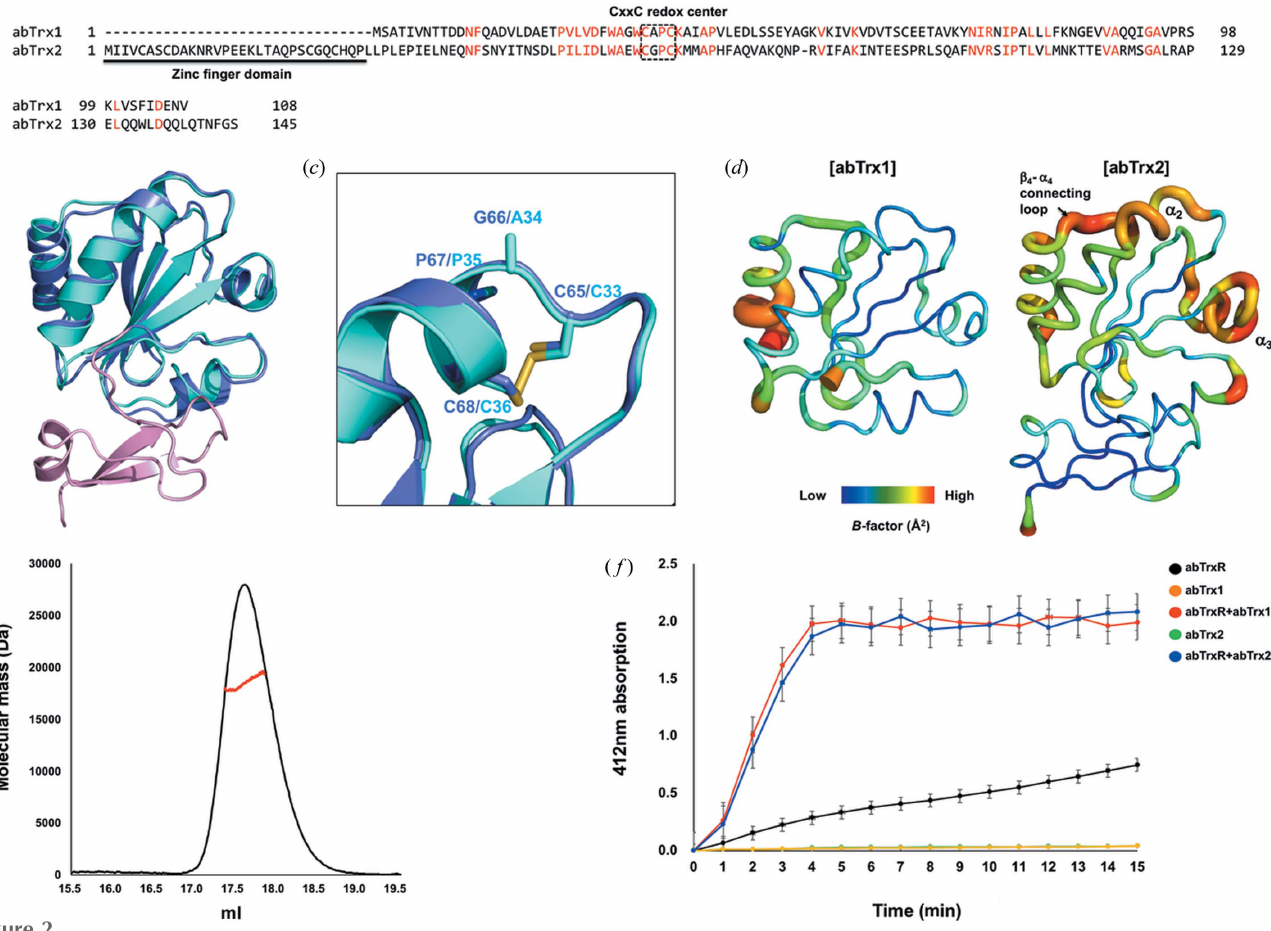
Figure 2 Structure and activity comparison of abTrx2 with abTrx1. ( a ) Sequence alignment of abTrx2 with abTrx1. Conserved residues are marked in red. ( b ) Superimposition of abTrx1 (cyan) and abTrx2 (blue and pink) for structural comparison. ( c ) A magnified view of the CxxC redox centers from the superposed structures of abTrx1 (cyan) and abTrx2 (blue). Residues forming the CxxC redox centers are labeled. ( d ) Comparison of B -factor distribution between abTrx1 and abTrx2. Putty representations are provided for visualizing B -factor distribution. ( e ) A MALS profile derived from the main SEC peak of abTrx2. The experimental MALS data (red line) are plotted as SEC elution volume ( x axis) versus absolute molecular mass ( y axis) distributions on the SEC chromatogram (black) at 280 nm. ( f ) Trx activity analysis by DTNB reduction assay. The reduction of DTNB by abTrxR was tested in the presence of abTrx1 and abTrx2. Error bars indicate the standard deviation for three independent experiments ( n =